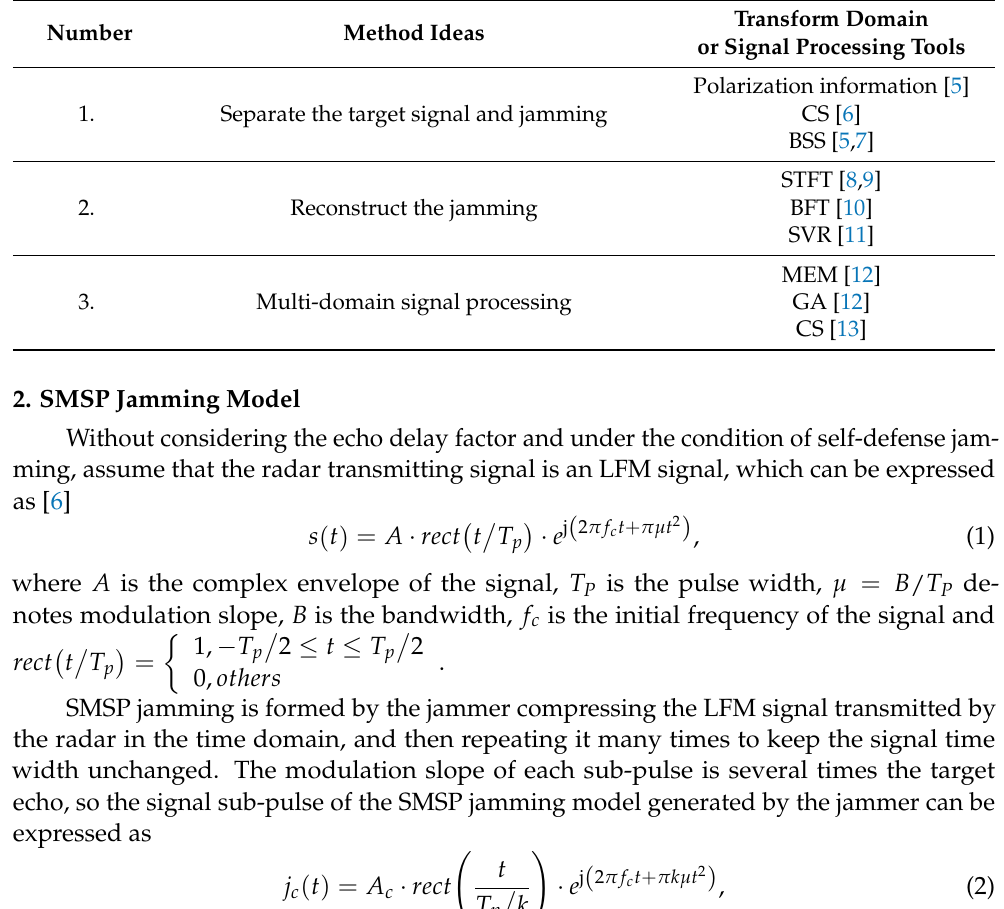
Table 1. summarize and